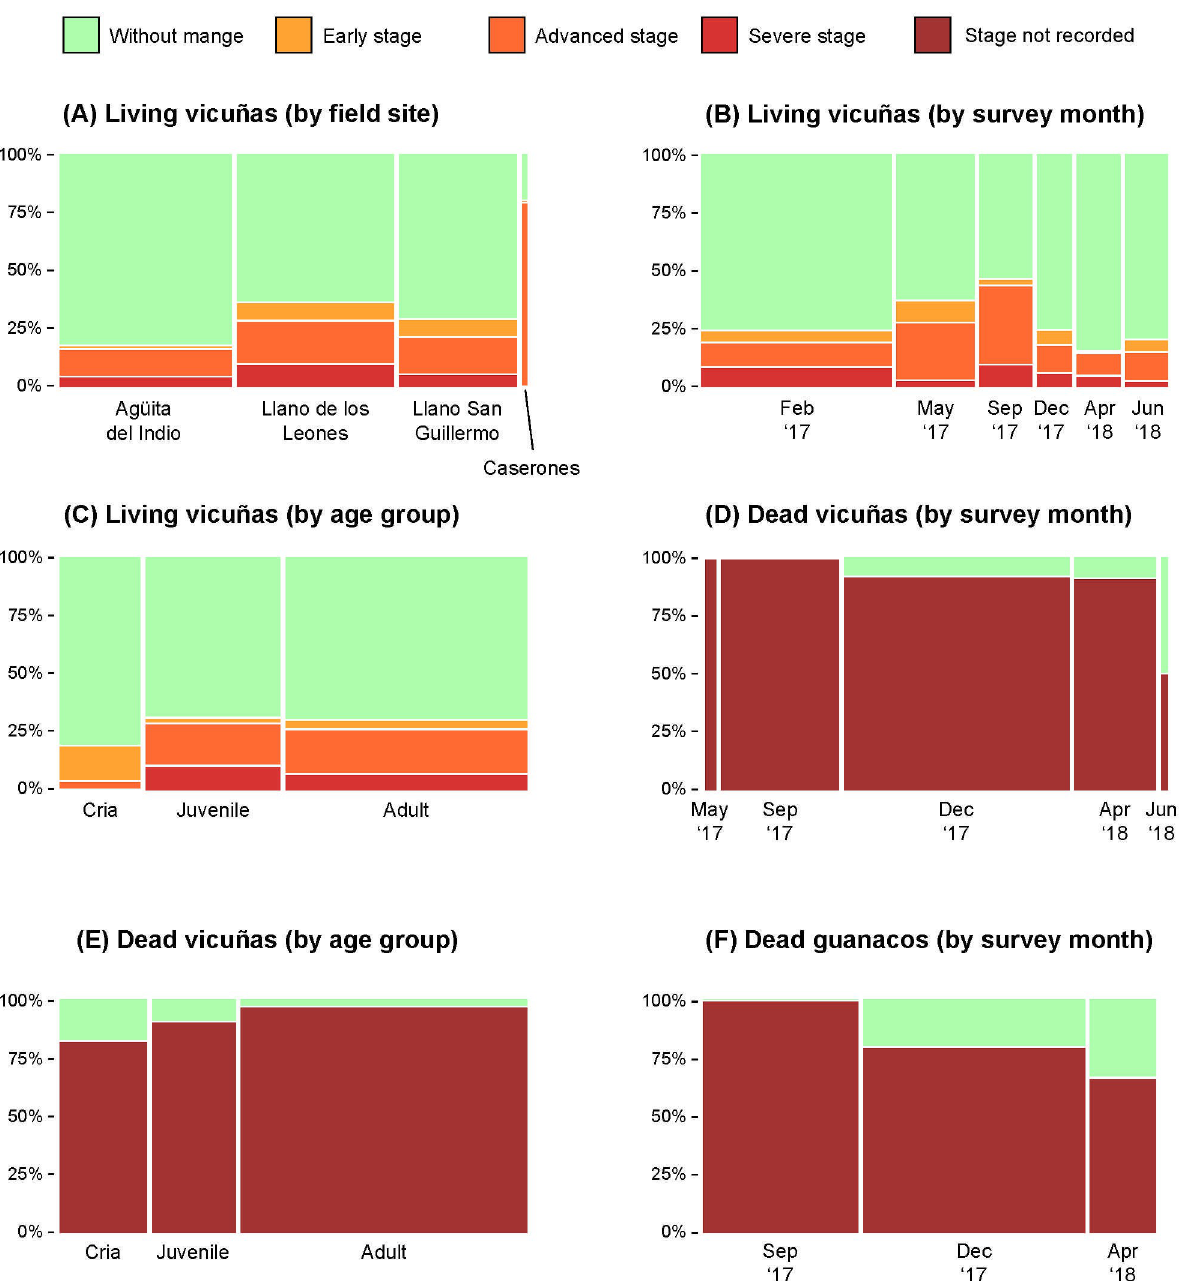
Fig 4. Mosaic plots of the proportion of individuals affected with mange according to the species, location, and survey month.